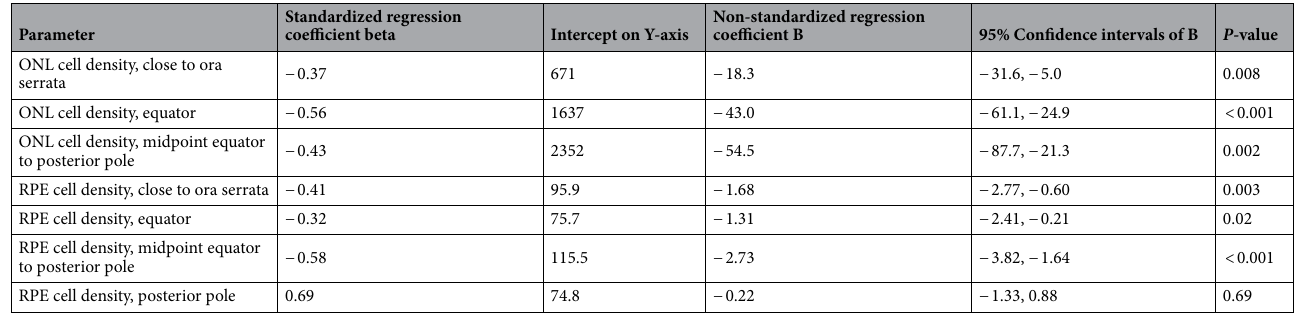
Table 3. Associations of the retinal outer nuclear layer (ONL) cell density and retinal pigment epithelium (RPE) cell density, measured in various ocular regions, with the distance between the ora serrata and the posterior